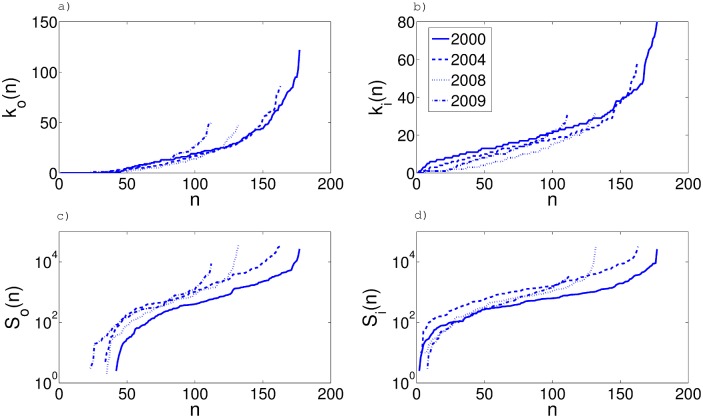
In this picture x-axis is the order of the node with respect to its value on the y-axis.The panel a) has out-degree on the y-axis, the panel b) has in-degree on the y-axis, the panel c) has out-strength on the y-axis and the panel d) has in-strength on the y-axis. The heterogeneity of all the properties is clear.